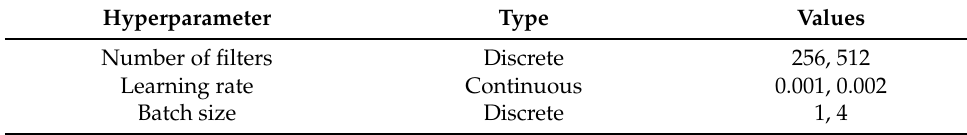
Table 2. Search Space Setup for Florence3D Dataset.